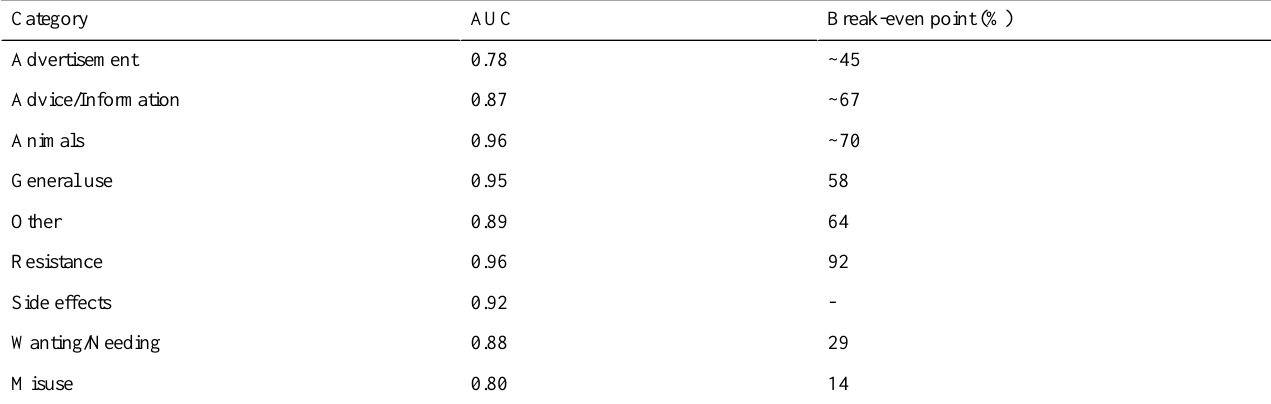
Table 4. The AUC and break-even values for per-class evaluation.